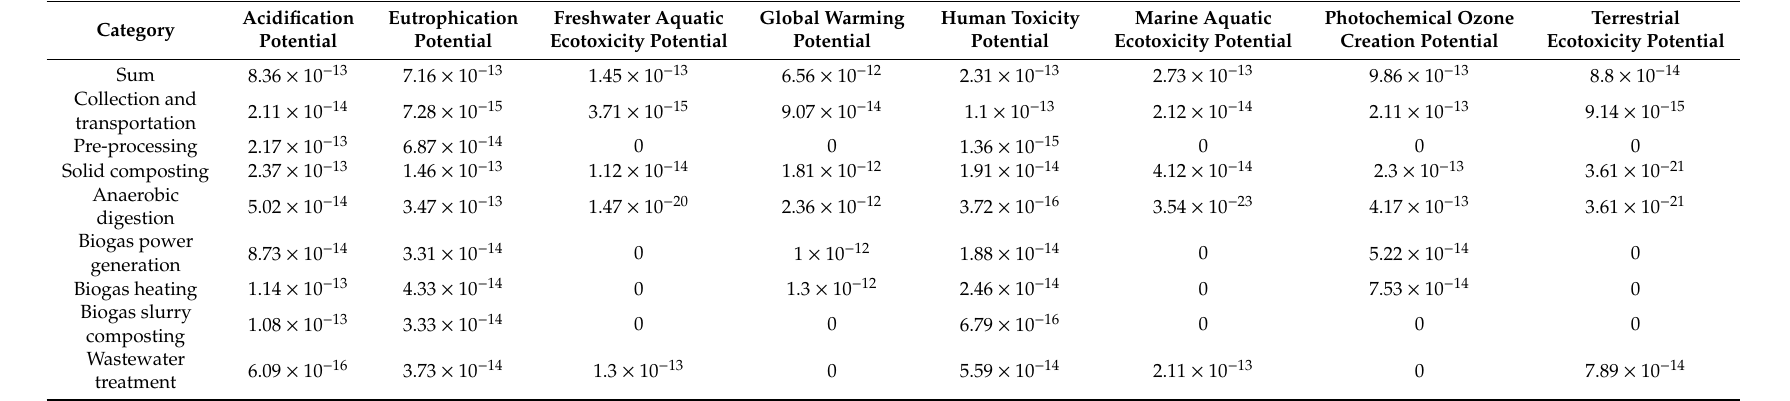
Table 4. Normalized value for each environmental impact